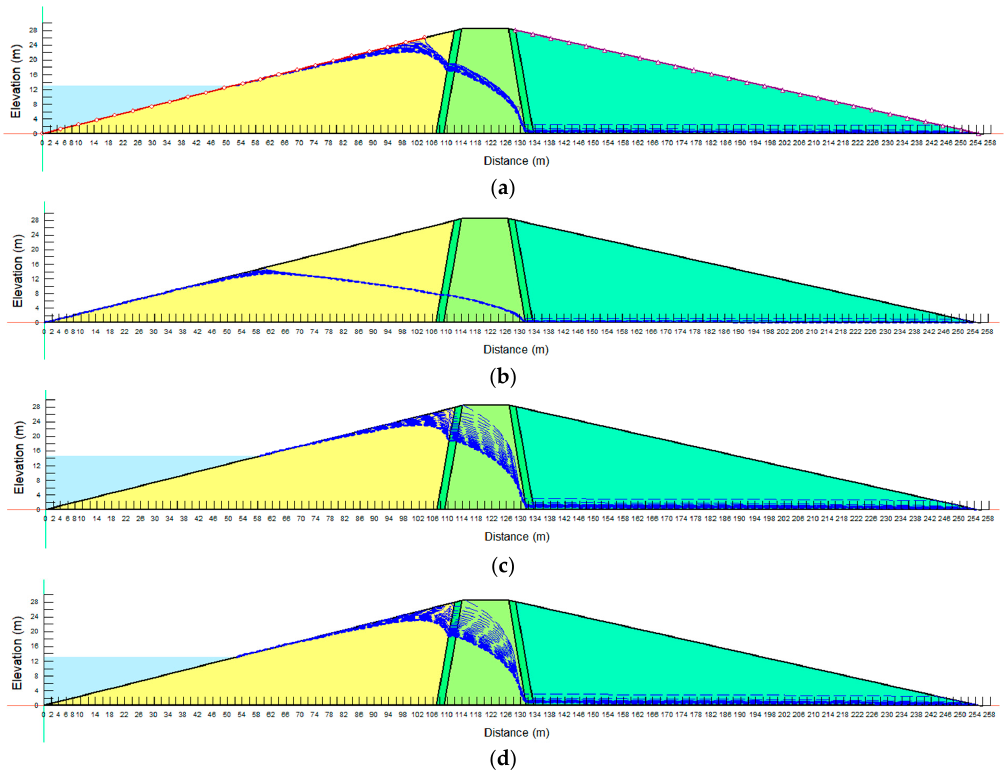
Figure 5. Rapid drawdown (1 m per day) seepage: ( a ) normal operating level, ( b ) rapid drawdown (1 m per day) seepage under reduced reservoir operating level, ( c ) embankment-height reservoir operating level, ( d ) overflow reservoir operating level.